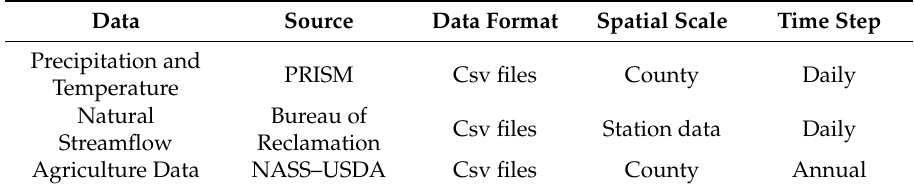
Table 1. Sources and format of